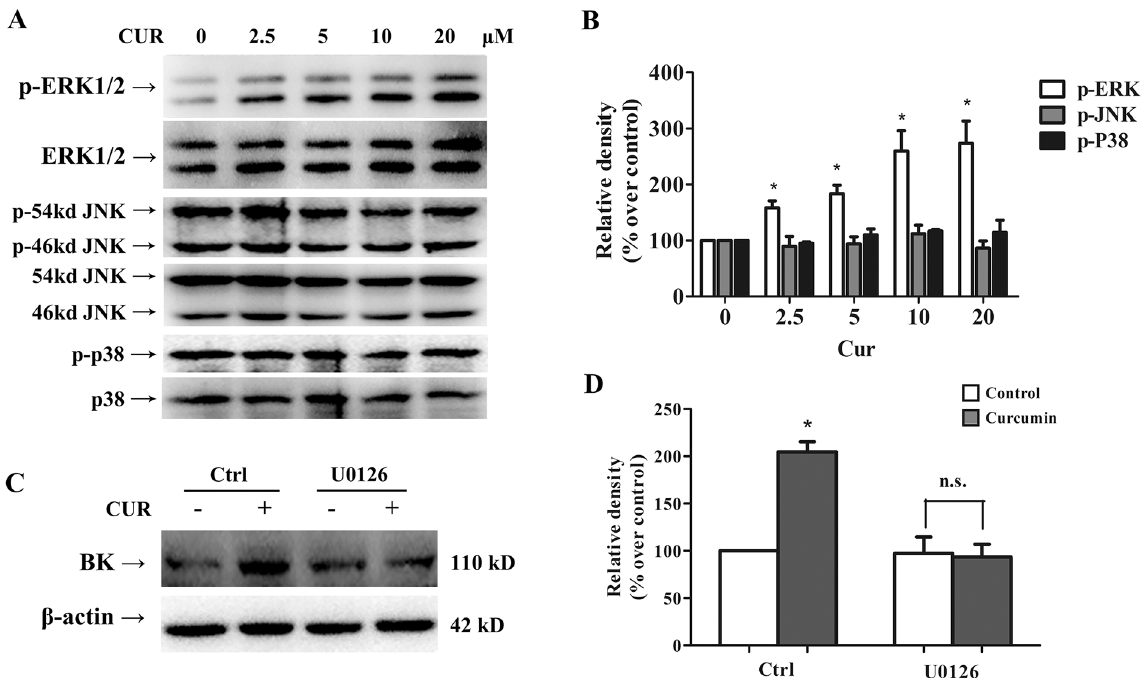
Fig 8. Curcumin up-regulated BK protein expression via ERK1/2 signaling pathway. (A) Effects of curcumin on ERK1/2, JNK, p38 phosphorylation. HEK293 cells were incubated with 10 μ M curcumin for 24 h, and the phosphorylation of ERK1/2, JNK, p38 were analyzed by Western Blot. (B) Graphic representation of densitometric data of the phosphorylation level of ERK1/2 (n = 3). (C) Western Blot analysis showed that the ERK1/2 inhibitors, U0126 (10 μ M), abolished the effect of curcumin on BK protein. Inhibitors were applied 1 h before administration of curcumin. (D) Graphic representation of densitometric data show a protein level of BK (n = 4). * p < 0.05; ** p < 0.01; n.s., not significant.